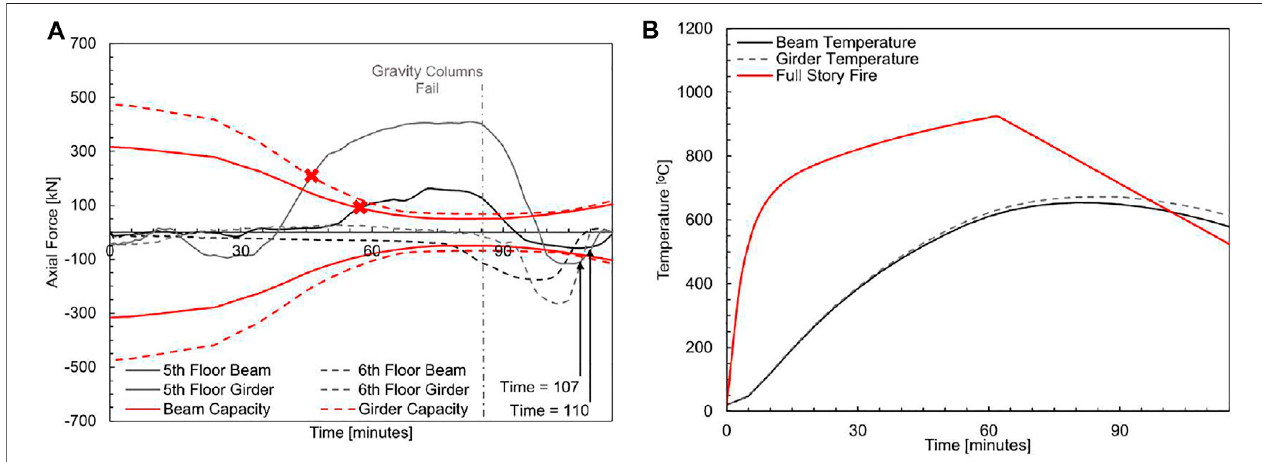
FIGURE 7 | (A) Axial force histories for beams and girders and (B) temperature histories of beams and girders in Fire Scenario #1.